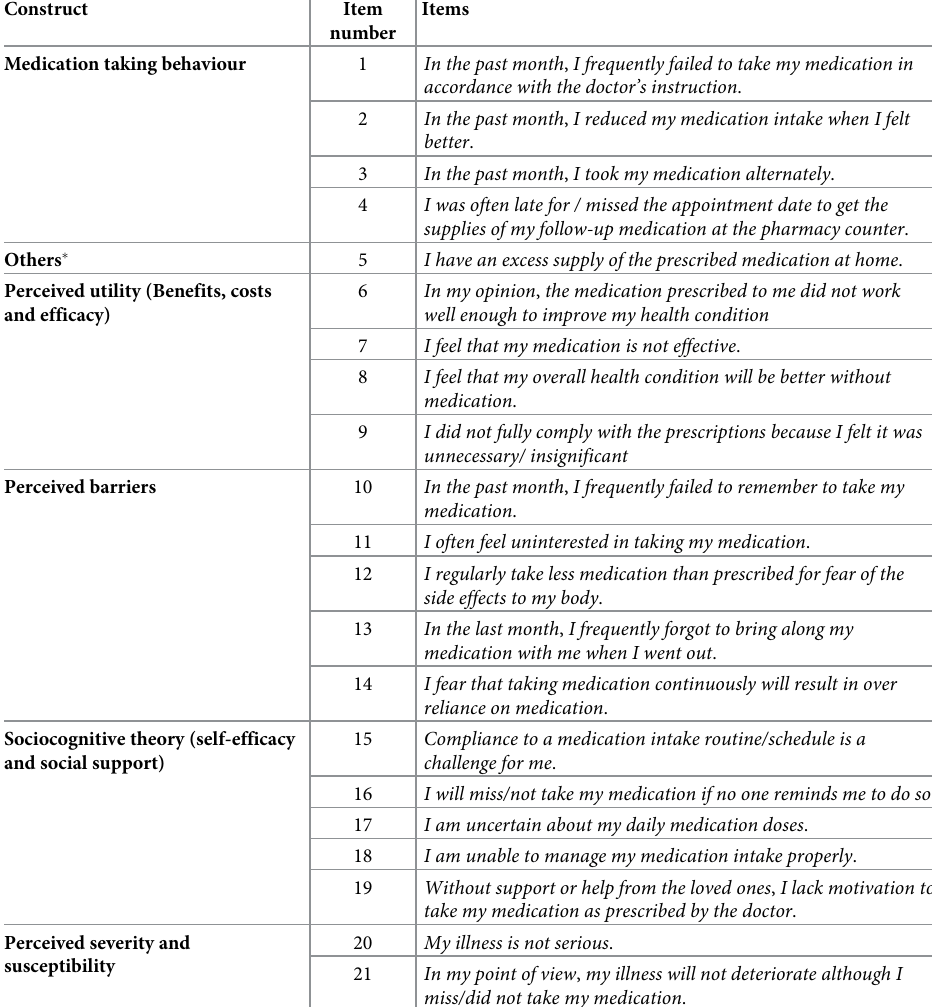
Table 1. The initial 21 items of MyMAAT and its preliminary